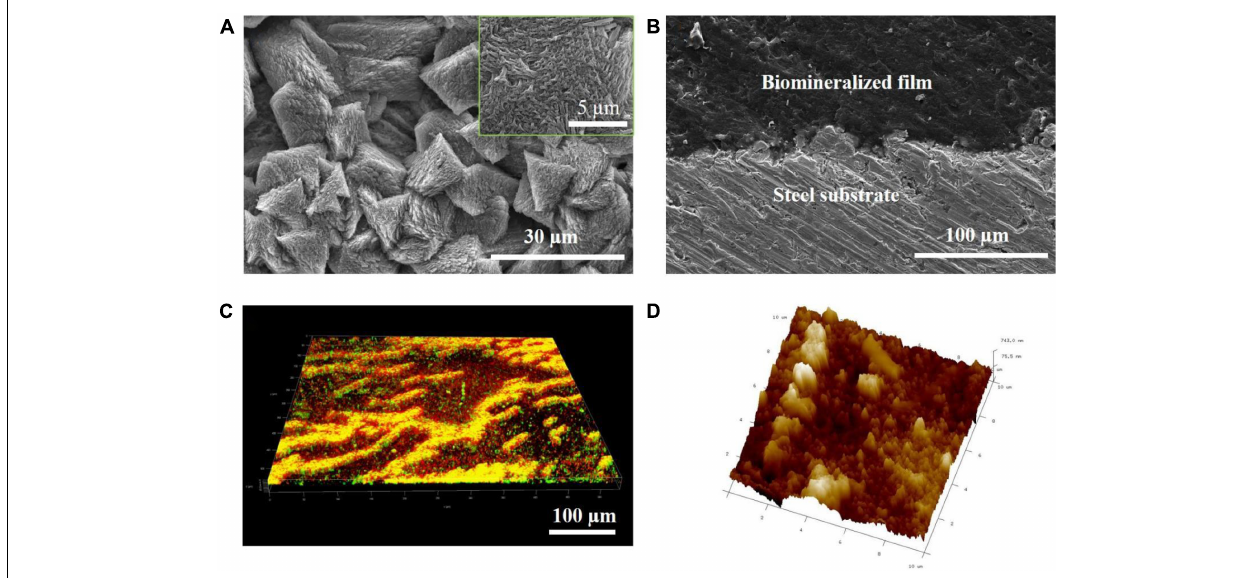
FIGURE 2 | Bacillus subtilis strain–induced calcite biomineralization on the steel surface. (A) Scanning electron microscopy (SEM) image of the morphology of the biomineralized film induced by the B. subtilis strain on day 3. (B) Cross-sectional SEM images of the biomineralized film induced by the B. subtilis strain on day 3. (C) LSCM images of the biofilm cells stained with the LIVE/DEAD Biofilm Viability kit on the steel surface on day 3 of the immersion test. Live cells are shown as green, dead cells as red, and partially damaged/dead cells as yellow. (D) Atomic force microscopy (AFM) image of the biomineralized film induced by the B. subtilis strain on day 3. The scanning size was 10 µ m × 10 µ m.